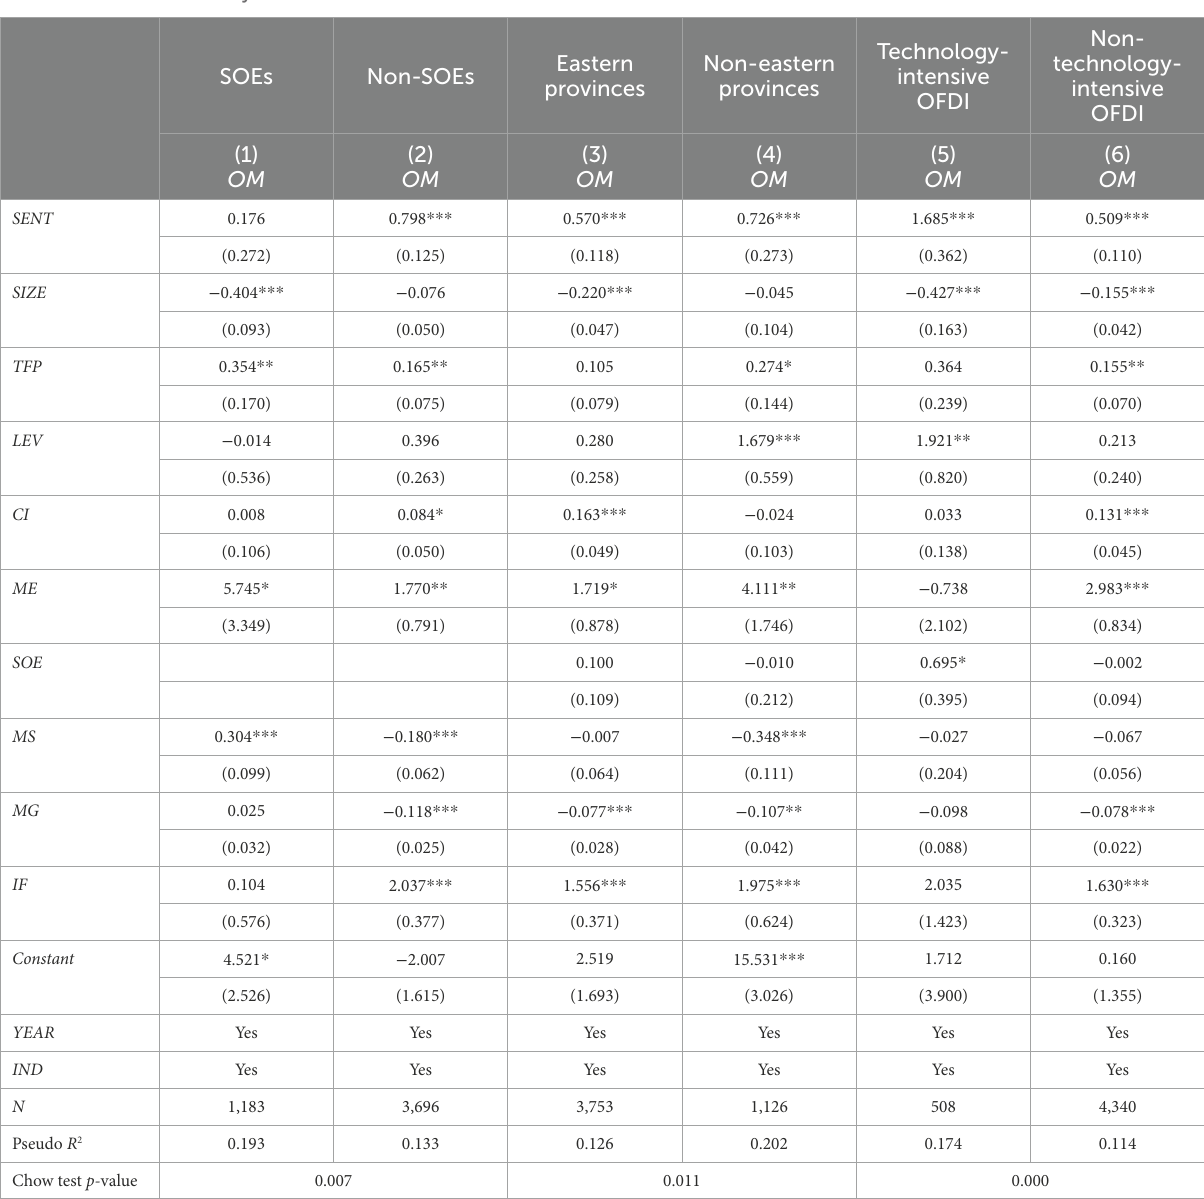
TABLE 6 Cross-sectional